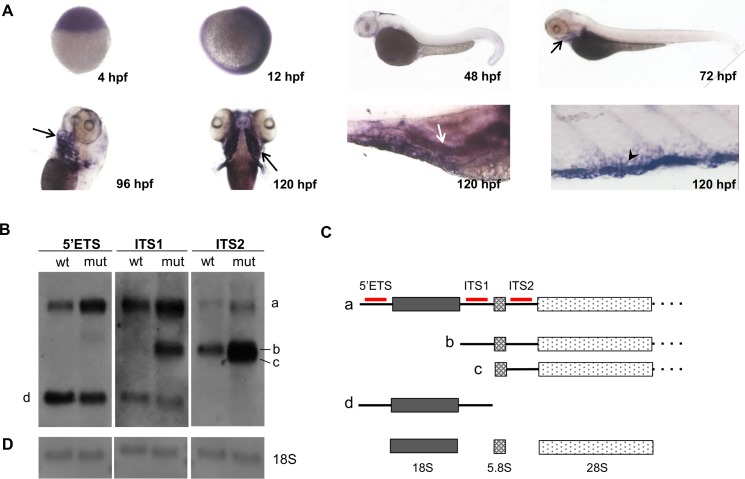
Loss-of-function nol9 mutation leads to a defect in ITS2 pre-rRNA processing.(A) Expression pattern of nol9 by WISH at sphere stage (4 hpf), 12 hpf, 48 hpf, 72 hpf, 96 hpf and 120 hpf. Black arrows indicate branchial arches, white arrow indicates pancreas and arrowhead indicates nol9-expressing cells in the CHT. (B) Representative Northern blot analysis of RNA isolated from 5 dpf nol9
sa102/sa10222 mutants and control (nol9
+/+ and nol9
+/sa1022) siblings using 5’ETS, ITS1 and ITS2 probes to detect rRNA processing intermediates. Corresponding rRNA intermediates (a, b, c, d) are indicated in B) and C). (C) Schematic representation of the rRNA intermediates detected in the Northern blot analysis. The sites of hybridization of the 5’ETS, ITS1 and ITS2 probes are indicated in red. (D) Methylene blue staining of the membrane was used to control for equal loading of RNA. wt–nol9
+/+/nol9
+/sa1022, mut–nol9
sa1022/sa1022.